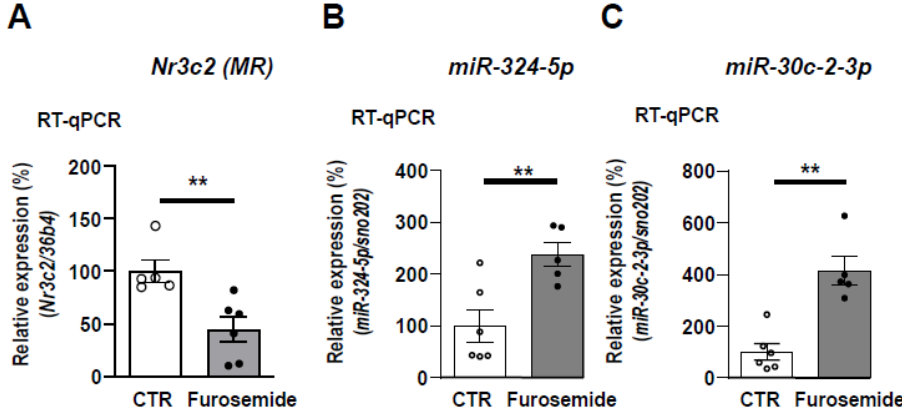
Figure 7. Treatment of mice with furosemide increases renal miR-324-5p and miR-30c-2-3p expression in vivo. Furosemide (40 mg/kg), an NKCC2 inhibitor, was administrated for 4 h before sacrifice to induce a relative luminal hypertonicity. RT-qPCR of Nr3c2 (MR) ( A ), miR-324-5p ( B ), and miR-30c-2-3p ( C ) expression in the kidneys of treated-mice compared to control mice, arbitrarily set at 100%. Data are means ± SEMs ( n = 5 – 6 animals). ** p <0.01 compared to control mice.